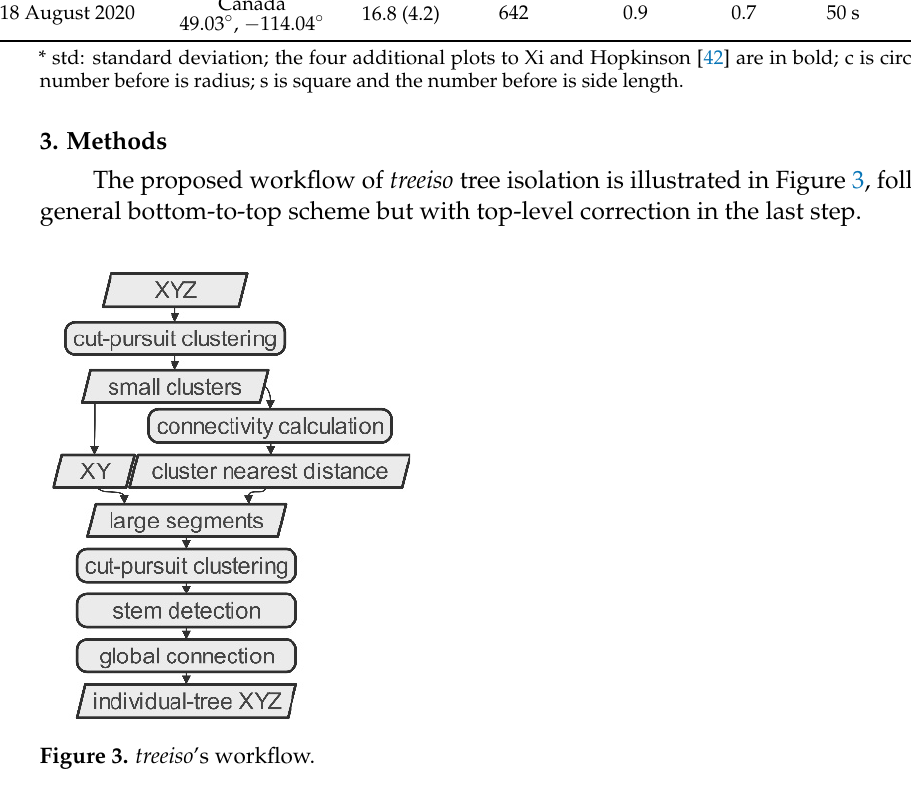
Figure 2. Manually isolated point clouds from sixteen TLS plot scans. Each individual tree was as ‐ signed a random color to help visual identification. Geolocations of eight Canadian sites with TLS scan collection. Ecozone names are Italic.